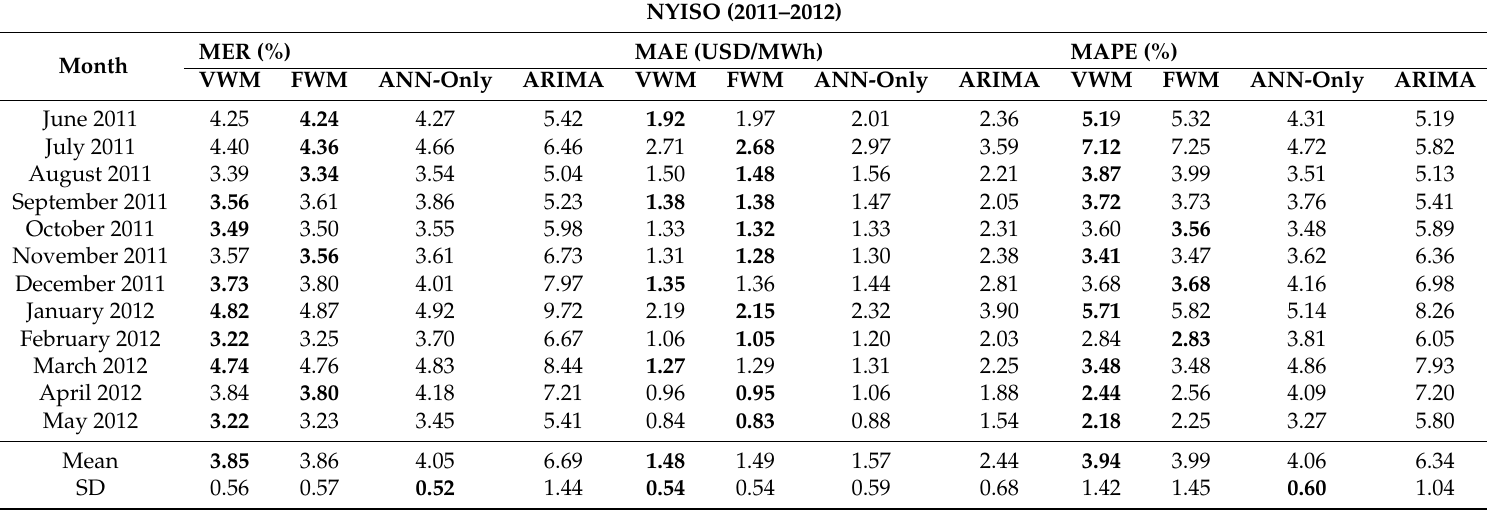
Table 5. MER, MAE and MAPE evaluation metrics for the NYISO market for the years 2011–2012 (Experiment